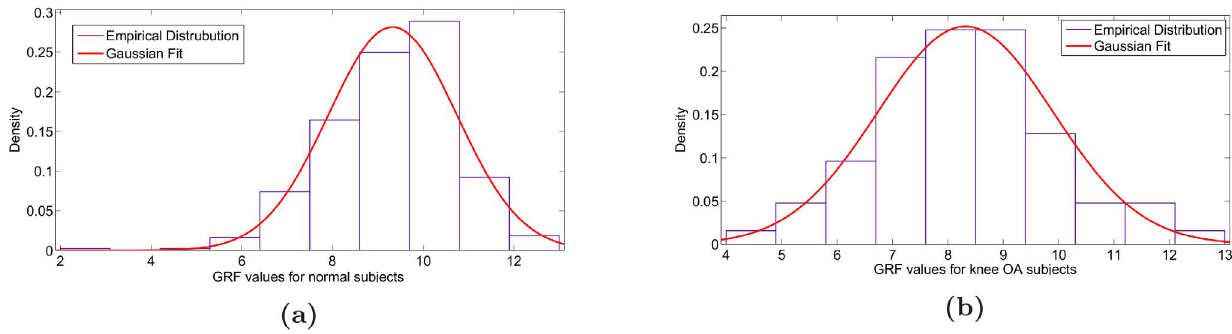
Figure 4. The goodness of fit of a Gaussian distribution to the actual empirical distribution of the GRFs patterns for (a) normal subjects and (b) knee OA subjects. Probability distributions over GRF patterns. Solid red lines is Gaussian distributions with mean and standard deviation matched to the empirical GRFs histograms. The data and the matching Gaussian distributions appear as bell-shaped.